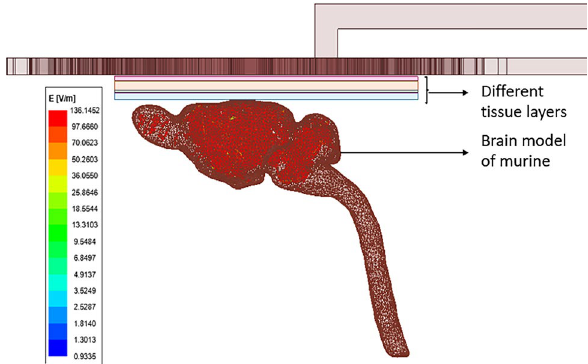
Figure 11. Simulation result of electric field intensity of murine brain model.